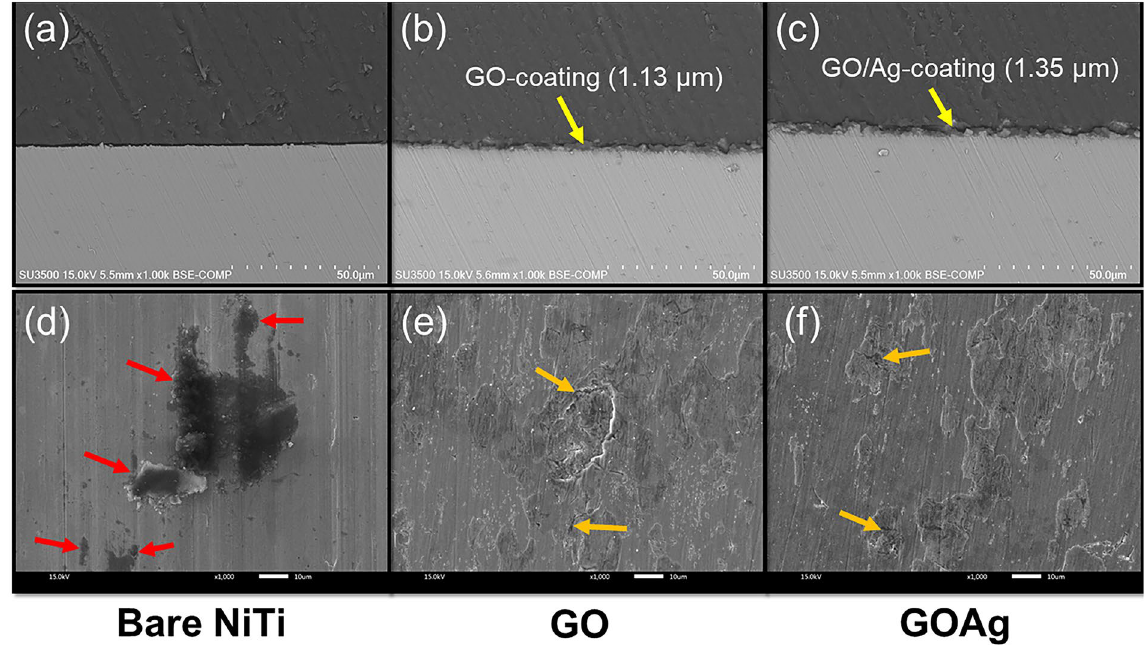
Figure 4. ( a – c ) The SEM analysis of the cross-section of the uncoated NiTi alloy, GO-coated NiTi alloy, and GO/ Ag-coated NiTi alloy. A layer of GO-coatings (~1.13 µ m) and GO/Ag-coatings (~1.35 µ m) were evident on the surface of GO-coated NiTi alloy, and GO/Ag-coated NiTi alloy, respectively. Thickness of the coatings were analyzed from the surface profilometer. ( d – f ) The surface morphology of the bare NiTi GO-coated NiTi, and GO/Ag-coated NiTi alloys following the potentiodynamic polarization experiments. The arrows indicate the pitting corrosion.